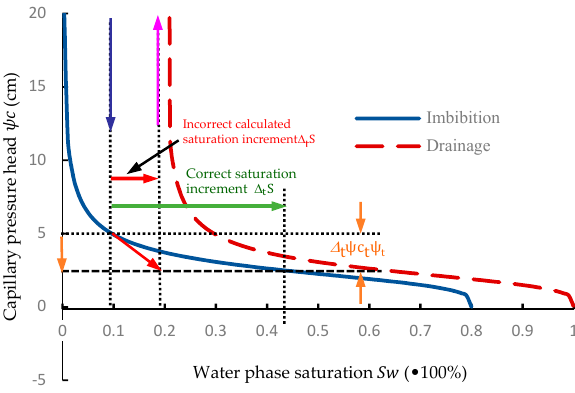
Figure 4. Illustration of inability of using single form formulation to model immiscible flow.